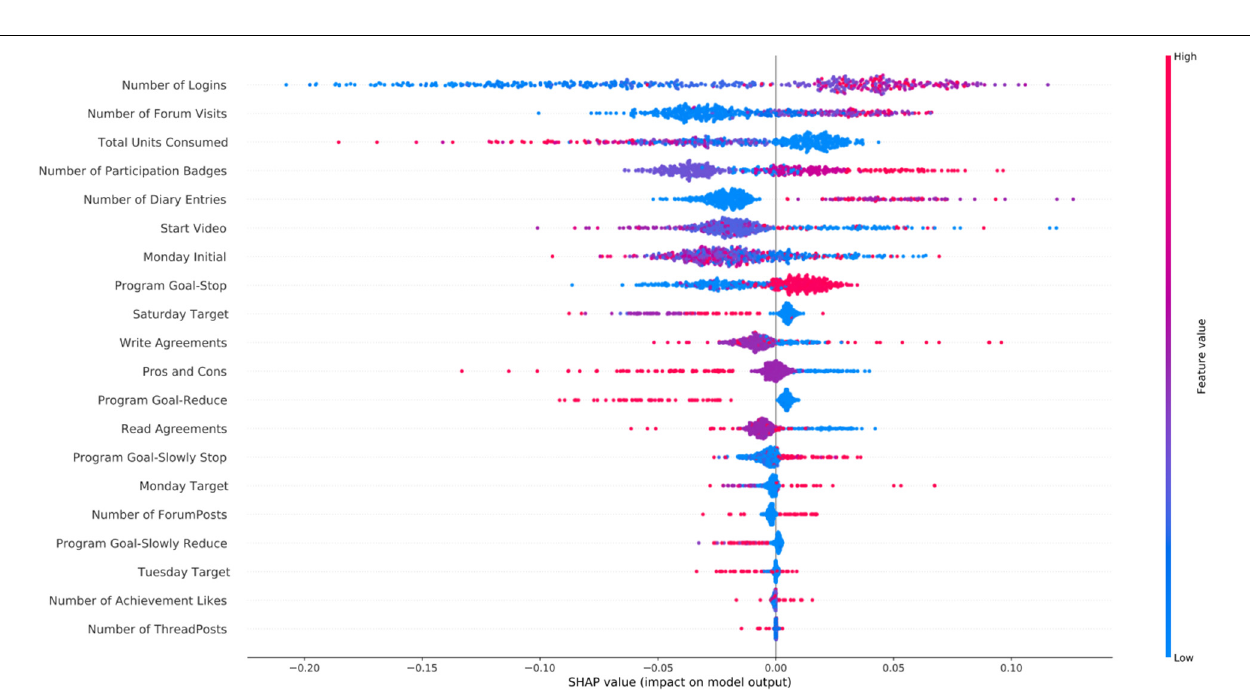
Frontiers in Psychology |